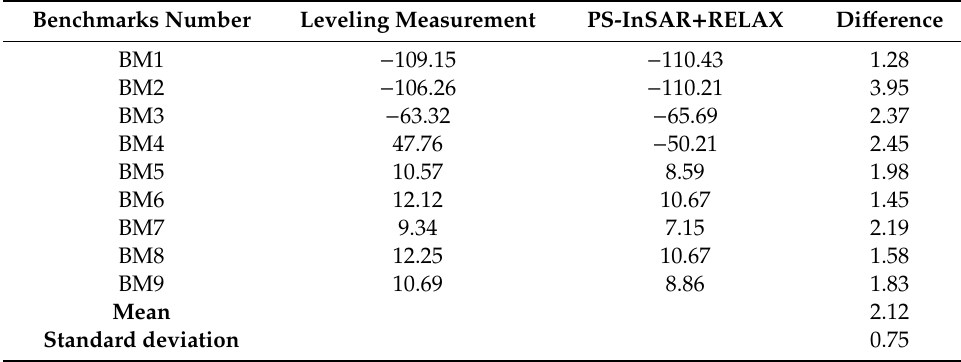
Table 5. ComparisonoflandsubsidenceresultsbyPS-InSAR + RELAXwithlevelingmeasurement(mm / year).